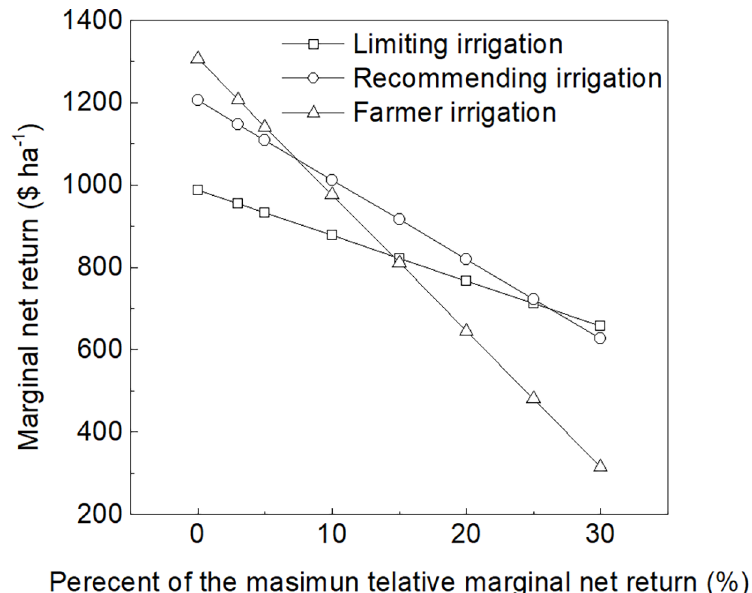
Fig 8. Simulated net return for different irrigation strategies over 22